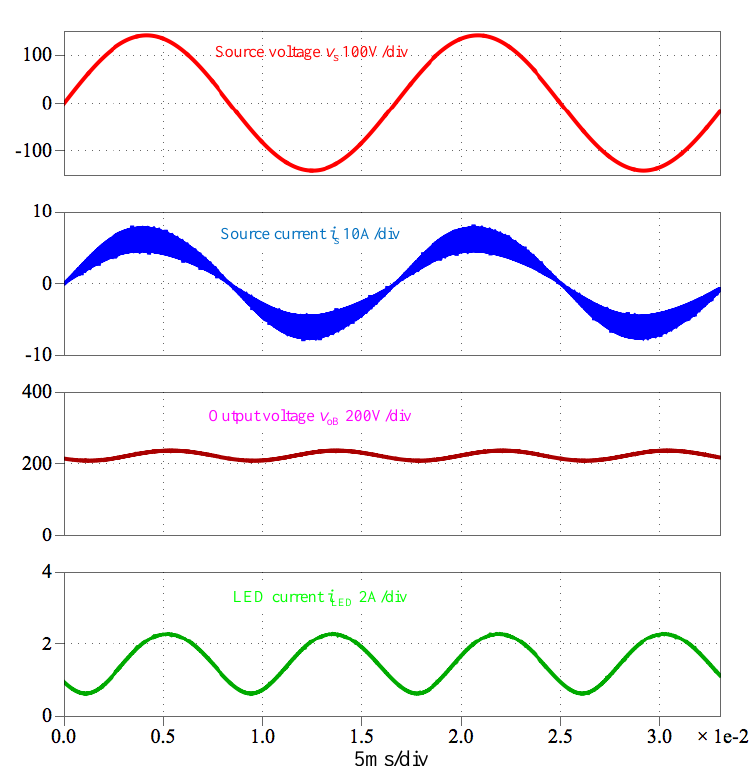
Figure 10. Simulation results of the proposed cooperative control method when the reference LED current I ∗ is 1.5 LED